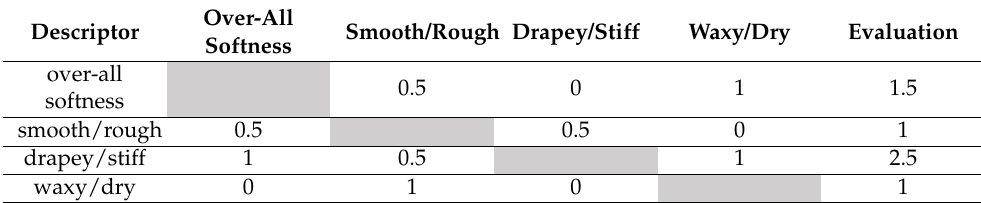
Table 2. Binary evaluation of